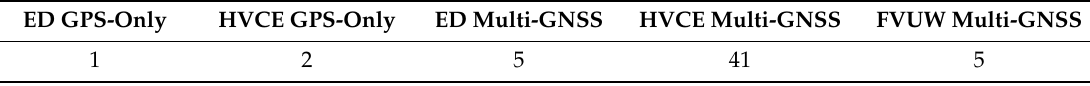
Table 7. Averaged time consumption at adjustment process per epoch for five strategies in the unit of